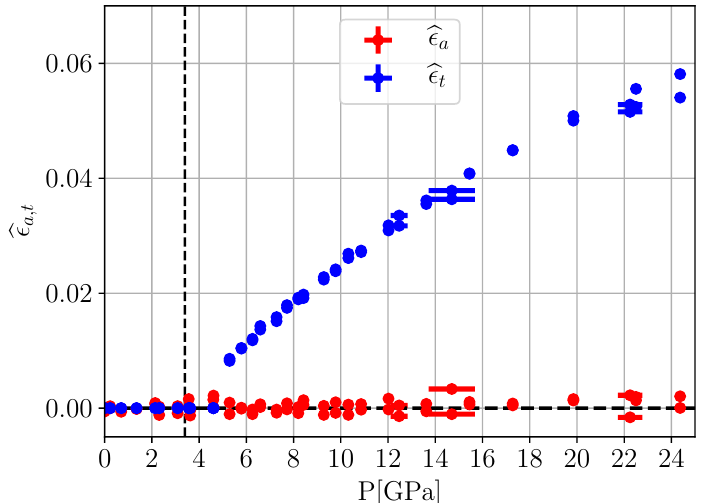
Figure 5. Lagrangian strains (cid:98) (cid:101) a , (cid:98) (cid:101) t calculated from unit cell data and Murnaghan fit of cubic part according to Ref. [11].